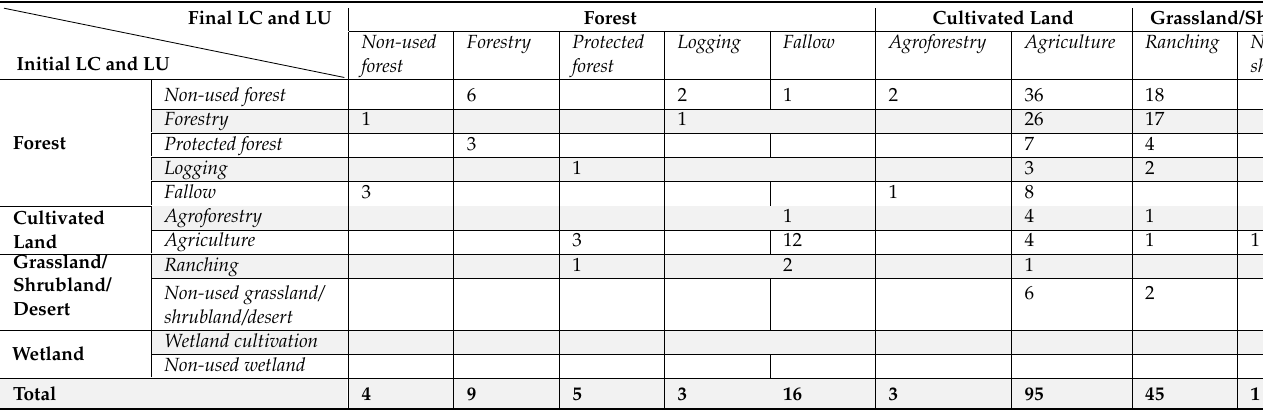
Table 1. Land-use (and cover) change of reviewed micro-level case